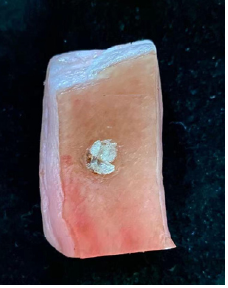
Figure 14. Pork skin with abnormal tissue mimicking phantom materials.